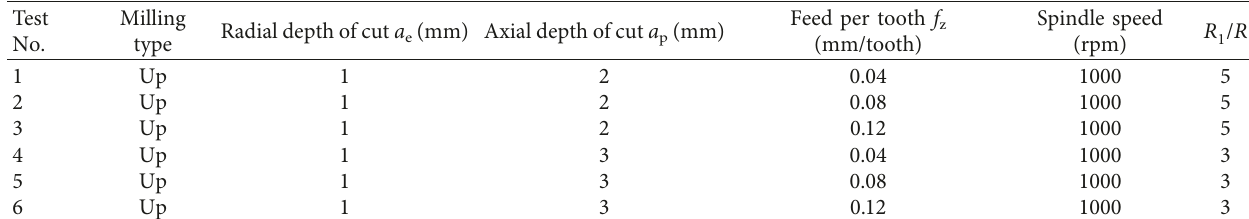
Figure 19: Discontinuous variation of measured forces. Table 6: Cutting conditions for the measurement with cutter entering along circular paths.